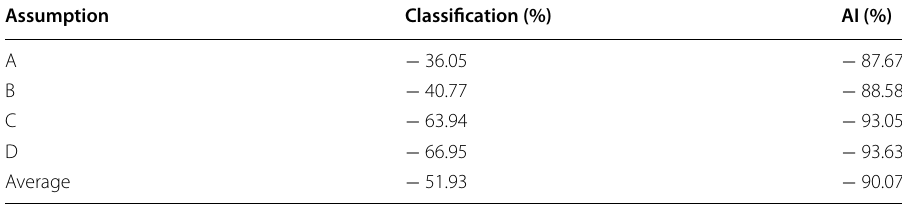
Table 6 Percentage cost difference for MinCost vs baseline methodologies Assumption Classification